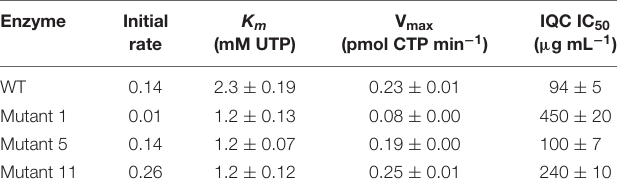
TABLE 3 | Characterization of the wild type and mutant CTPS enzymes. Enzyme